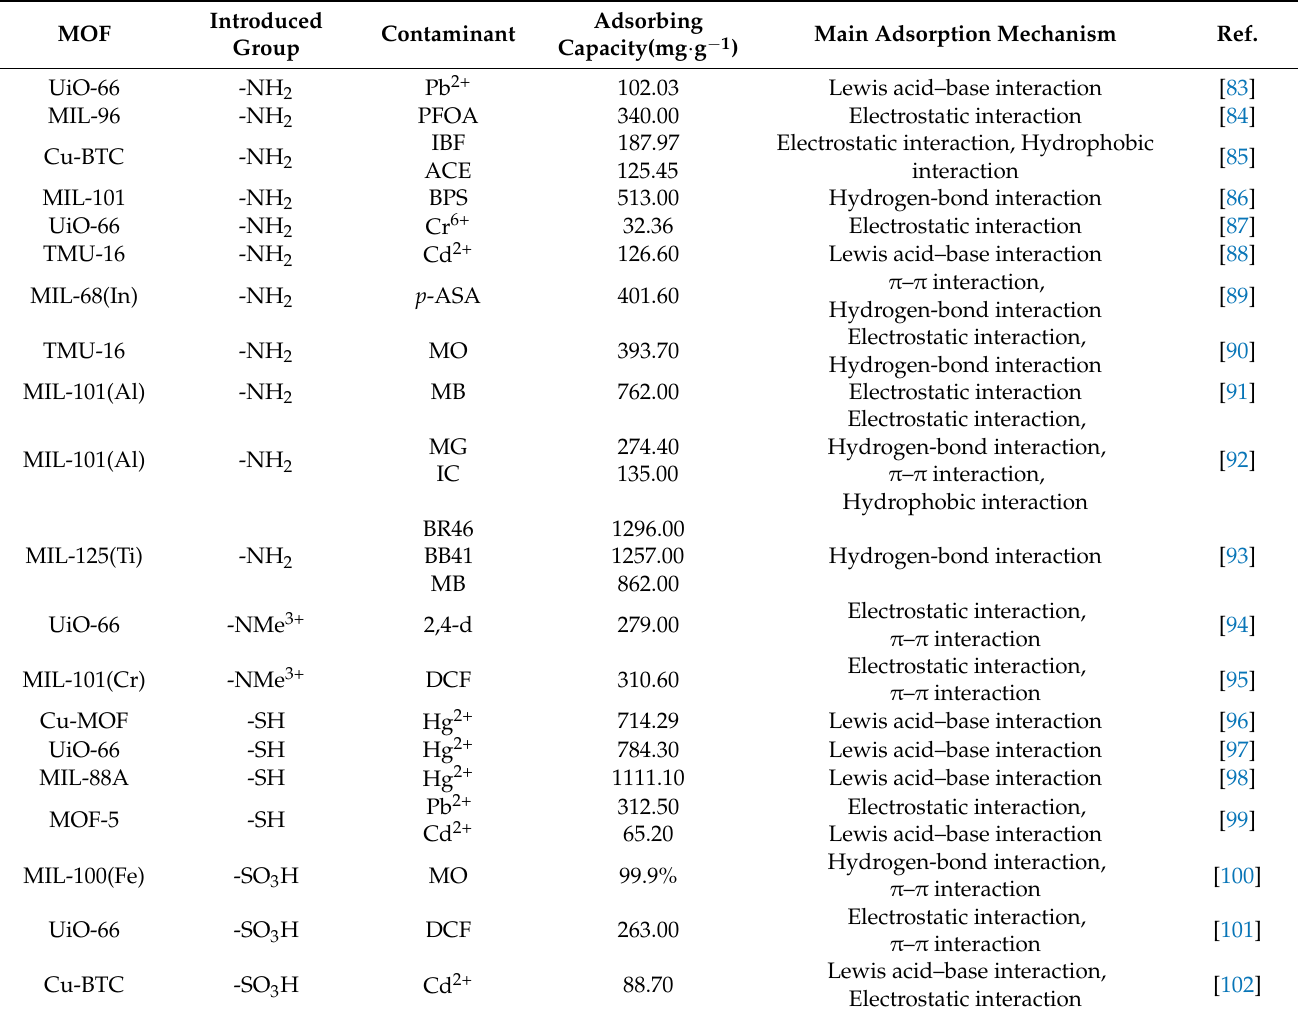
Table 1. Application of MOFs modified by functional groups in water